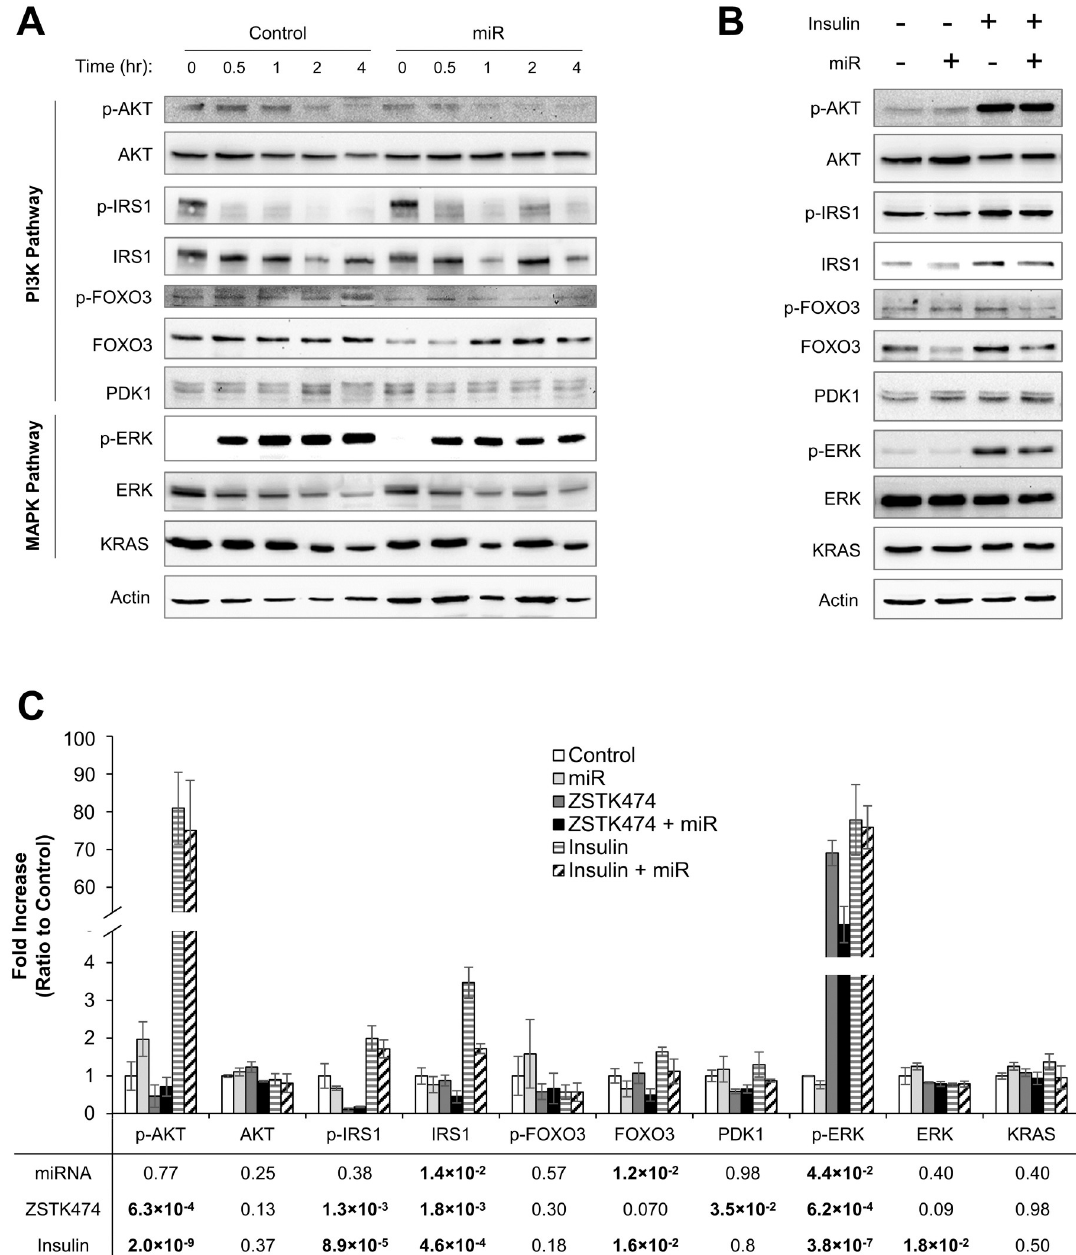
Fig 8. Expression of PI3K and MAPK pathway proteins are mediated by miR-105 and miR-767. (A) A549 cells were treated with negative control miRNA (Control) or miR-105 and miR-767 mimics (miR) for 24 hours, followed by 0.3 μ M ZSTK474. Cells were collected at 0, 0.5, 1, 2, and 4 hours after drug treatment. (B) Control and miR-treated A549 cells were incubated with insulin for 2 hours and protein expression was measured. (C) Protein expression was quantified using three replicates per treatment condition. ANOVA was performed and the p-values of main effects of miRNA, ZSTK474, and insulin are reported. Data are normalized to Control and presented as mean ± SEM.